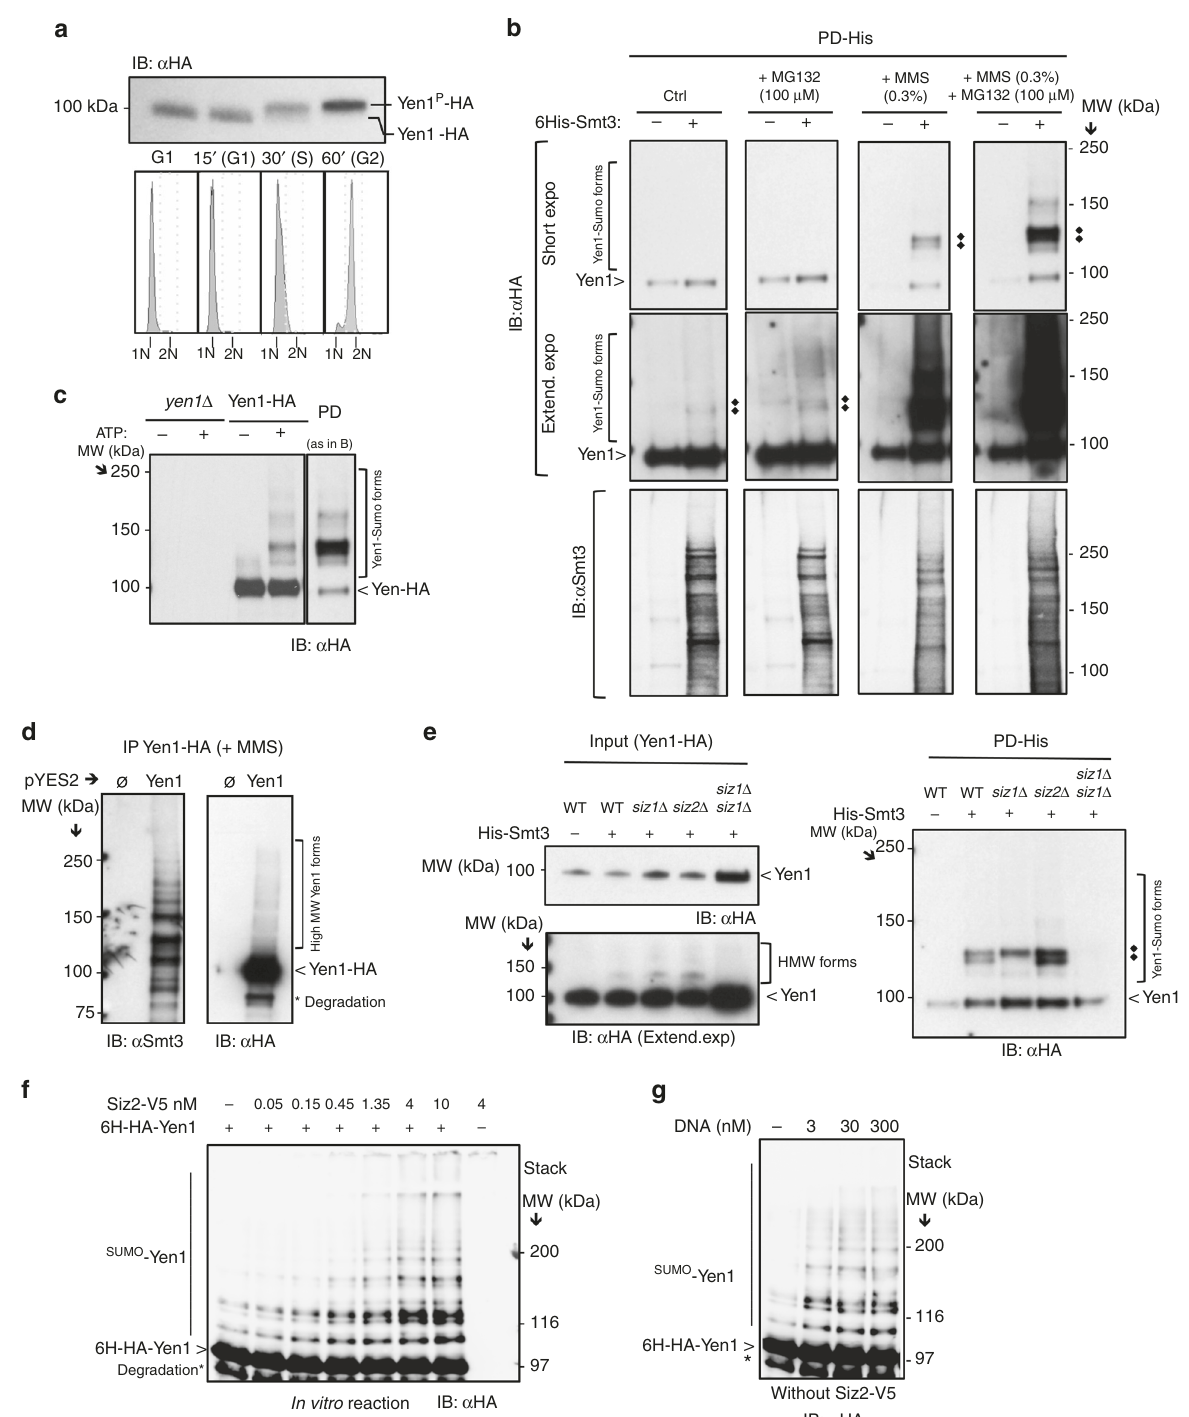
(Supplementary Figure 1d). To directly test the possibility that the Yen1 sumoylation is stimulated by its substrates, we analysed Smt3 pull-downs from a dna2 Δ pif1 strain. It has been shown that Yen1 is important in eliminating replication- dependent recombination intermediates in this strain 38 . observed in dna2 Δ pif1 cells (Supplementary Figure 1d). This supports the idea that sumoylation of Yen1 occurs in a context where Yen1 activity is